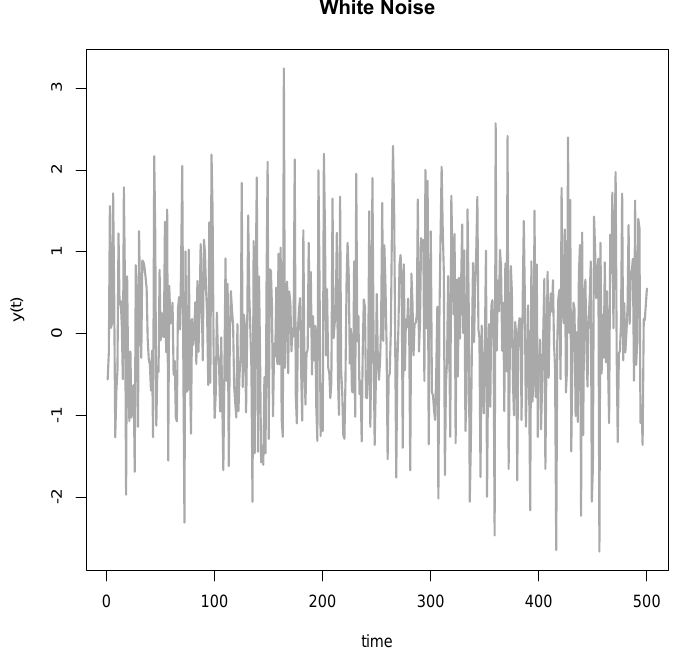
Figure 2. Simulated data highlighting an interesting spike around t = 148 explained by Shakespeare’s 148th Sonnet to illustrate the dangers of post hoc hypothesizing (HARKing). y(t) represents the hypothetical outcome variable .